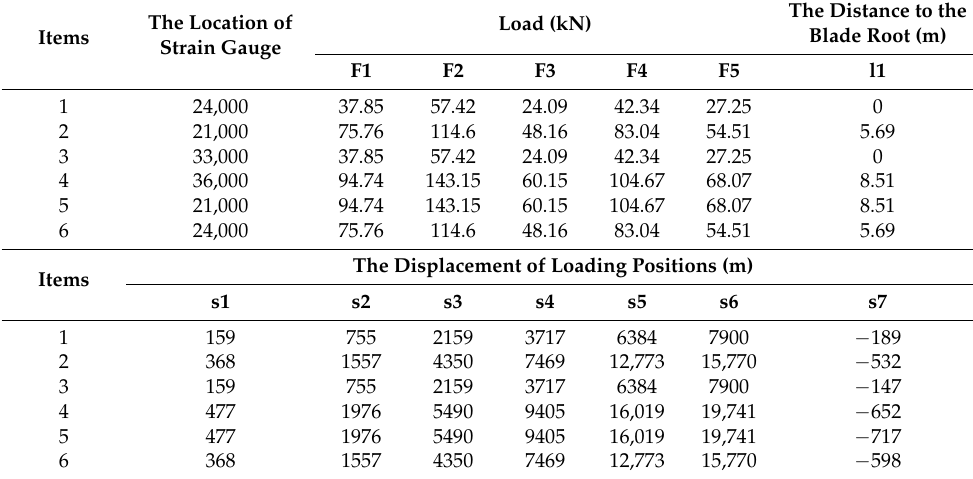
Table 8. The test samples of the GA-BPNN.